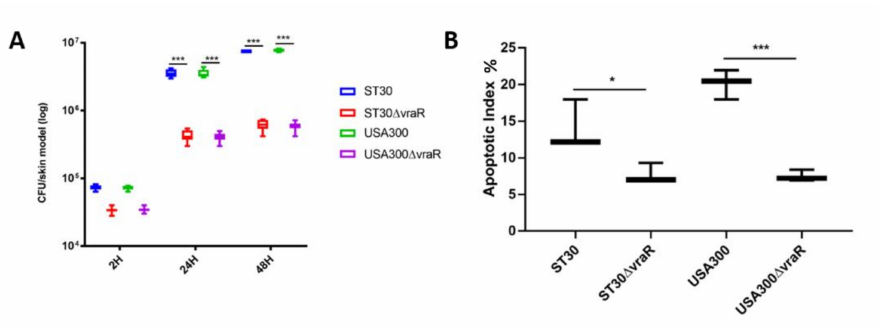
Figure 2. ( A ) The bacterial enumeration of adherent and internalized bacteria upon infection of the 3D-skin model. Data are shown as the means ± SD, significance were determinant by two-way ANOVA followed by Dunnett’s multiple comparison test. The p -values were obtained by comparing the mean of the treatments of the skin model at each time point and coded as *** p < 0.001. ( B ) The apoptotic index was measured to determine the amount of cell death induced by the bacterial infection. The error bars represent the standard deviation of the mean values. Significance was obtained by one-way ANOVA followed by Dunnett’s multiple comparison test. The p -values were obtained by comparison between the mean of the treatments of the skin model and coded as * p < 0.05 and *** p <